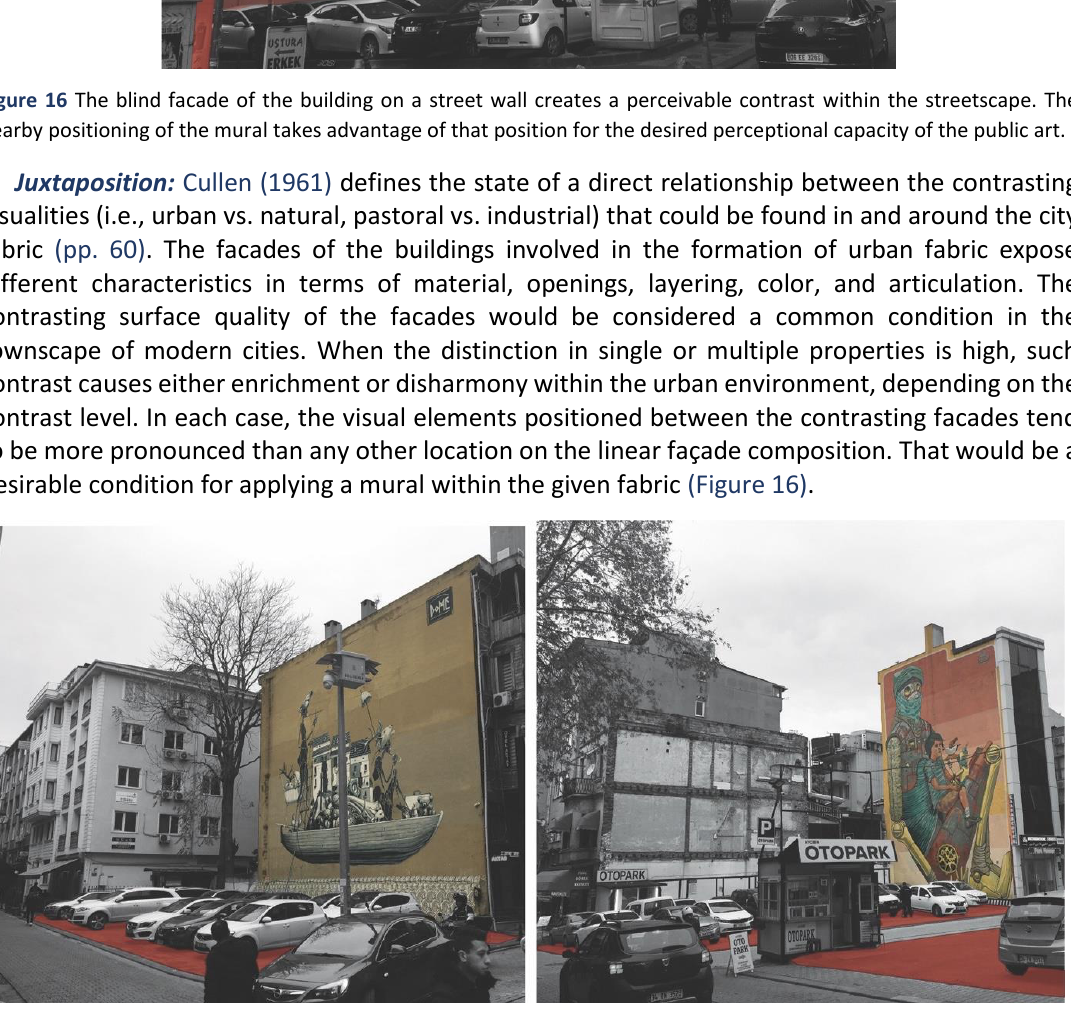
Figure 17 An observable match between the parking lots and the murals: such a coupling condition creates a characteristic